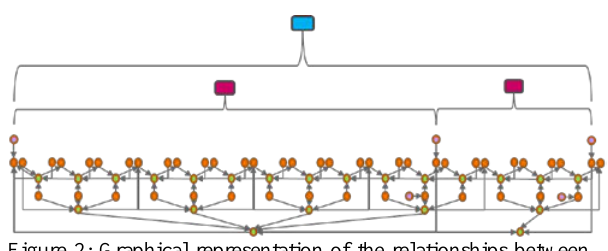
Figure 1: Graphical representation of the relationships between the observations (orange), known constant values (purple), and strap-down integrated quantities (red, green, and blue) on a local scale.